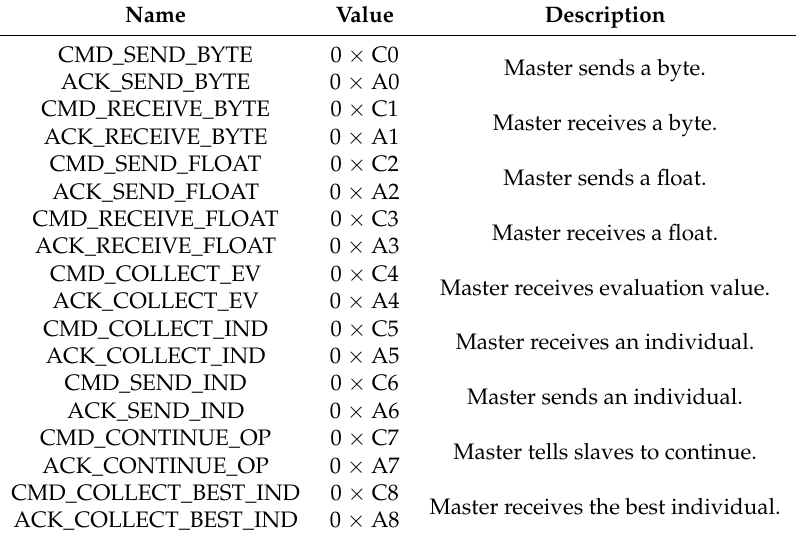
Figure 8. Example of how the the protocol based on commands and aknowledge messages works. Table 1. List of commands and aknowledge messages used by the proposed